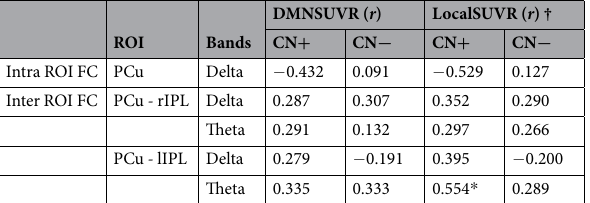
not show any group differences in the gray matter volume (Supplementary Fig. S1 and Supplementary Table S1). Further, additional analyses using the cortical volume within the DMN-related ROIs as confounding covariates